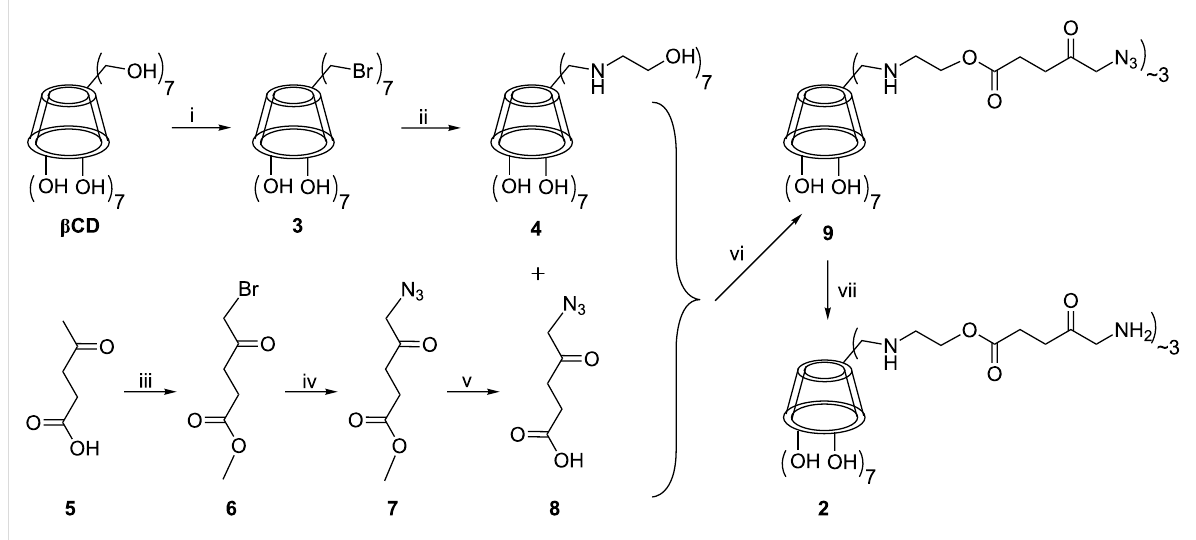
while the relative broadness of the signals indicated incomplete/ random substitution, allowing, however, the assignment of peaks via the HSQC-edited spectrum (Supporting Information File 1, Figure S3). The ratio 8 to 4 was ~3, as indicated by inte- gration of the respective signals and also confirmed by MALDI–TOF MS measurements ( m / z 1853, Supporting Infor- mation File 1, Figure S4), whereas the IR spectrum exhibited the characteristic stretching vibrations of the azido group